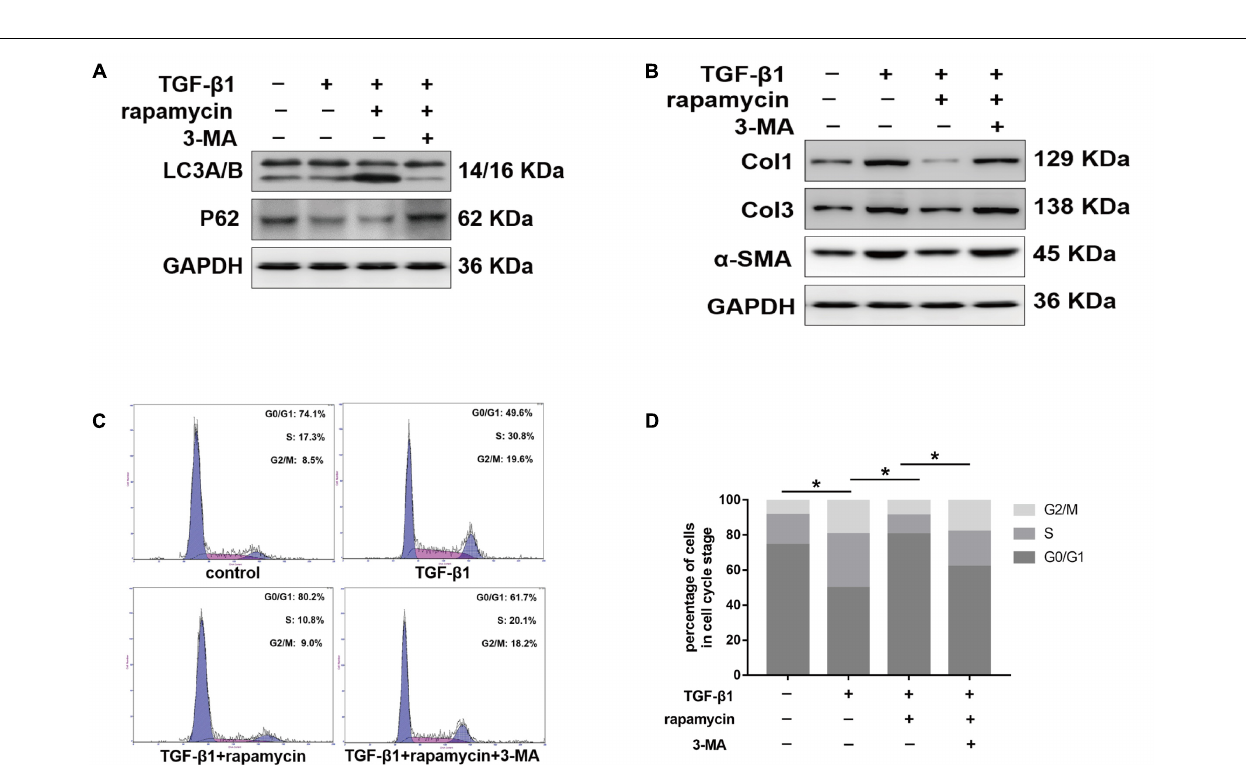
Frontiers in Pharmacology |